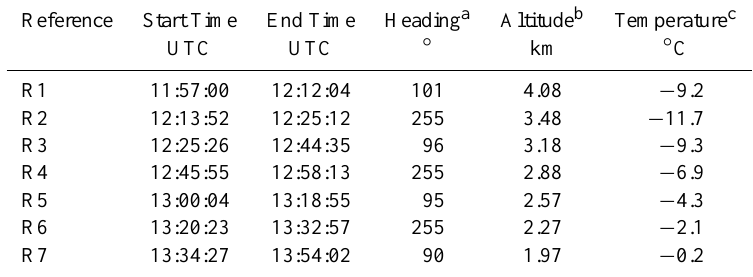
Table 1. Summary of constant altitude runs conducted by the FAAM BAe146 aircraft along a CFARR radial on 18 February 2009. Reference Start Time End Time Heading a Altitude b Temperature c